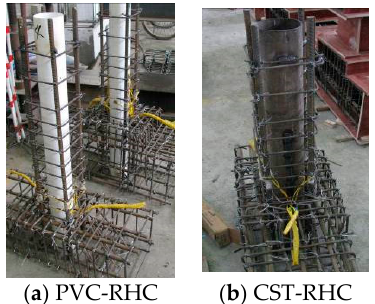
Figure 2. Internal skeleton of specimens.